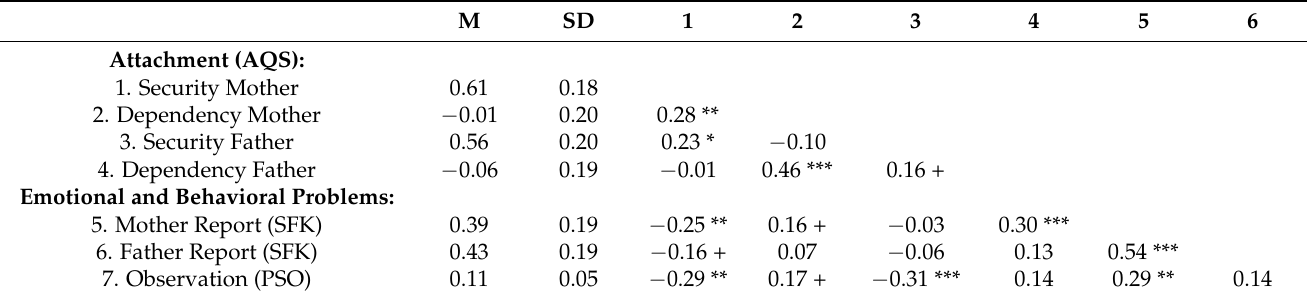
Table 1. Means, standard deviations, and correlations of all